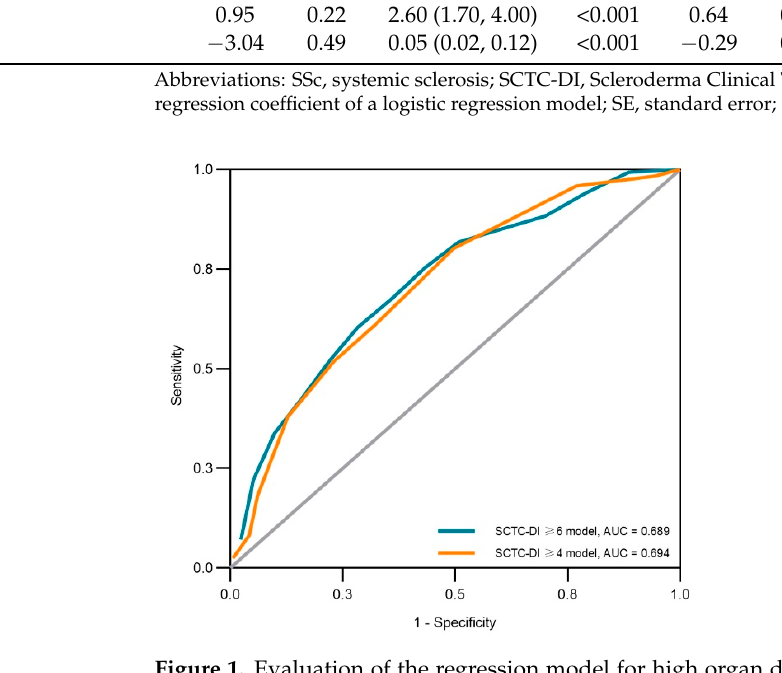
Figure 1. Evaluation of the regression model for high organ damage burden. Receiver operating characteristic (ROC) curves for the multivariate logistic model discriminating Scleroderma Clinical Trials Consortium Damage Index (SCTC-DI) low- and high-burden groups using the original beta weights of variables. Anemia, age, and steroid usage were included in the SCTC-DI ≥ 6 model. Anemia and disease duration were included in the SCTC-DI ≥ 4 model. AUC, area under the curve.